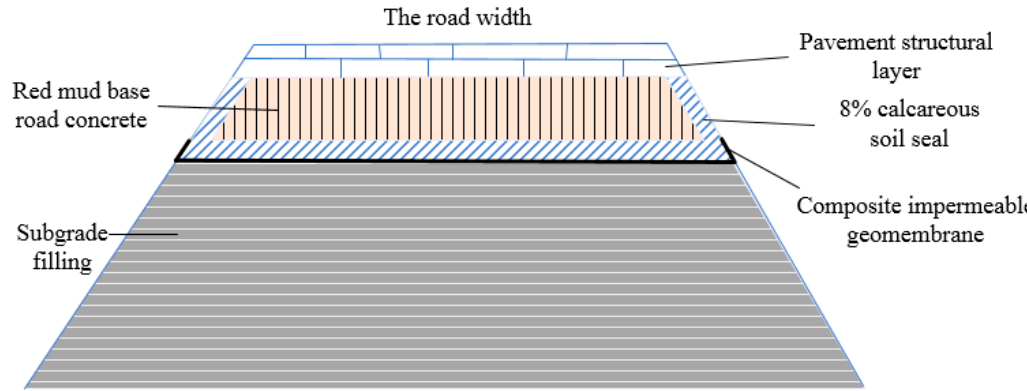
Figure 7. Construction diagram of RM pavement [87].